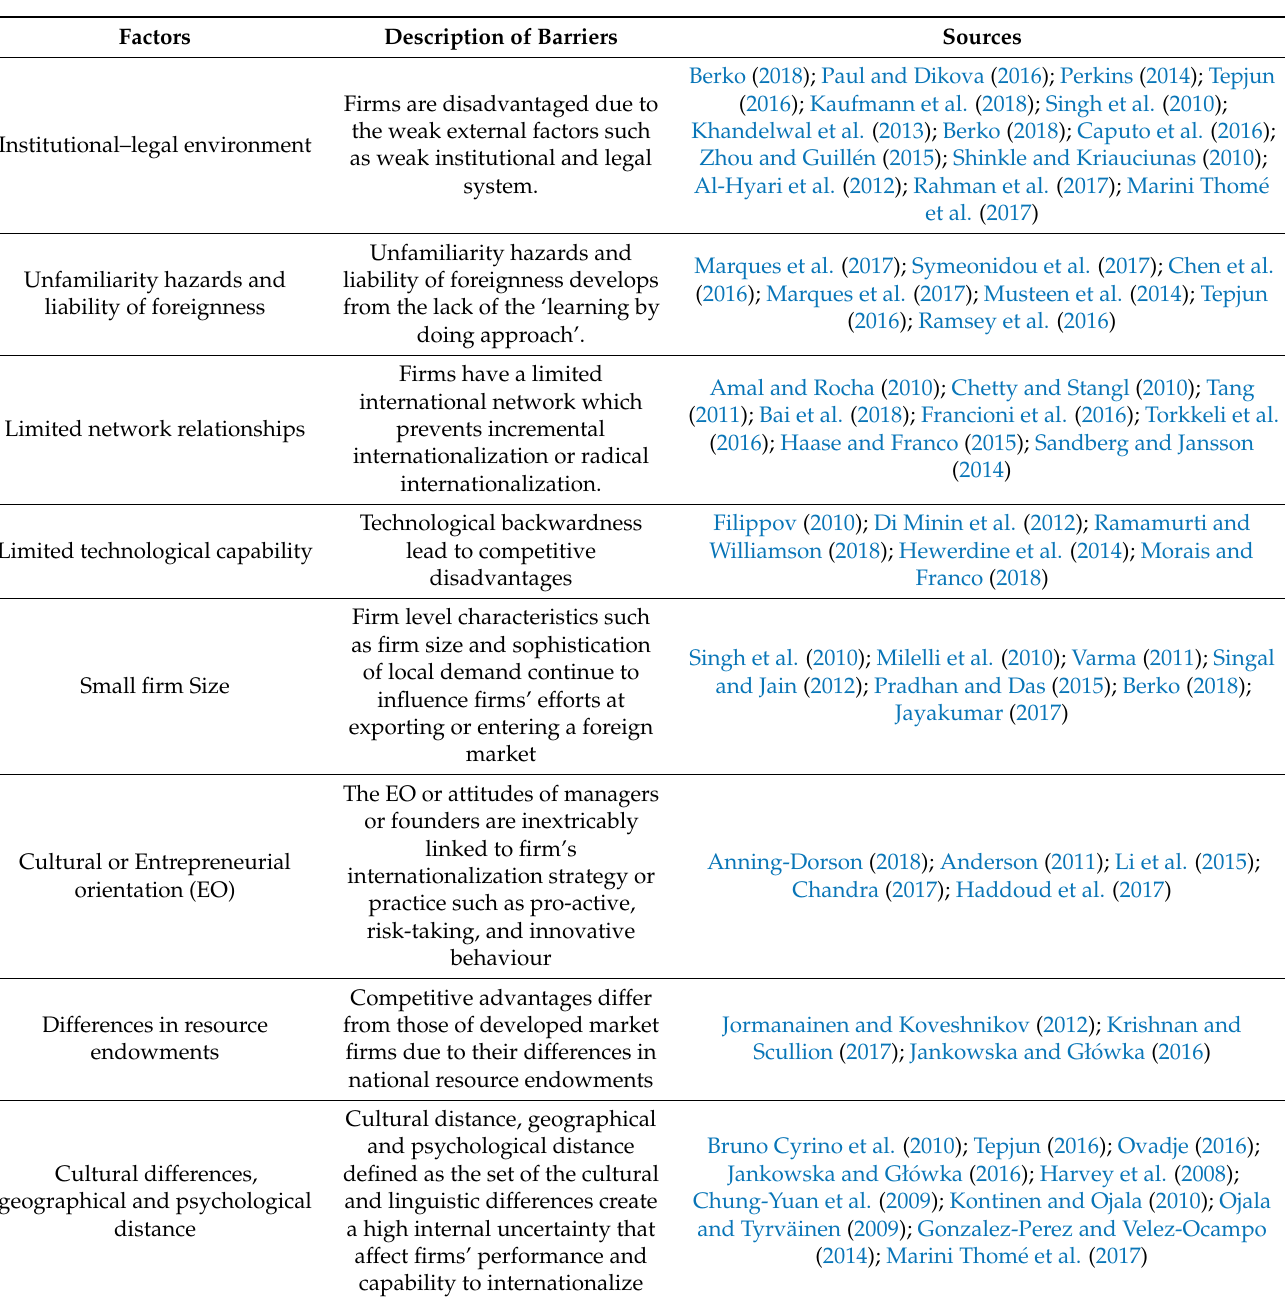
Table 2. Determinants of firm’s speed or early internationalization